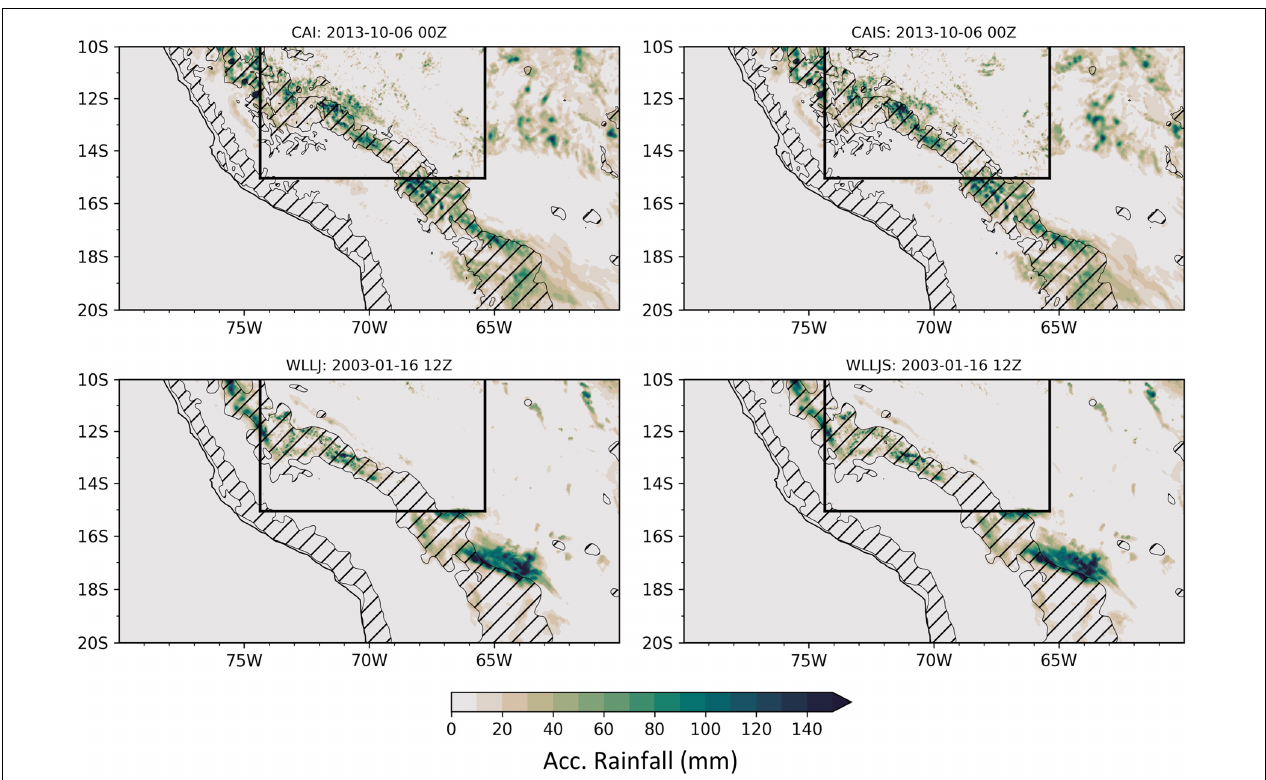
FIGURE 8 | Map of rainfall accumulation for CAI and CAIS (top row) and WLLJ and WLLJS (bottom row) WRF simulations over D02. The box delineates D03.